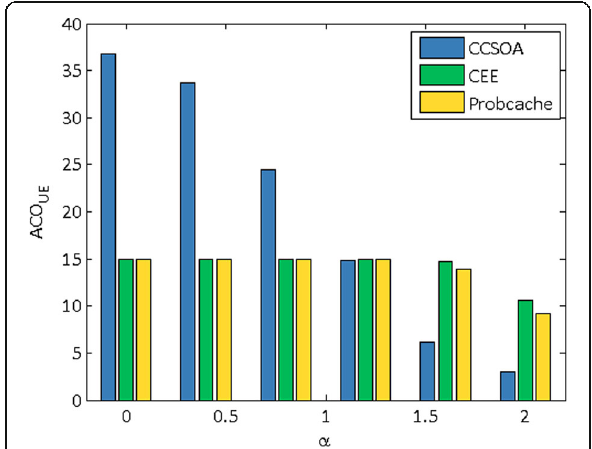
Fig. 23 Impact of Γ to ACO with different network